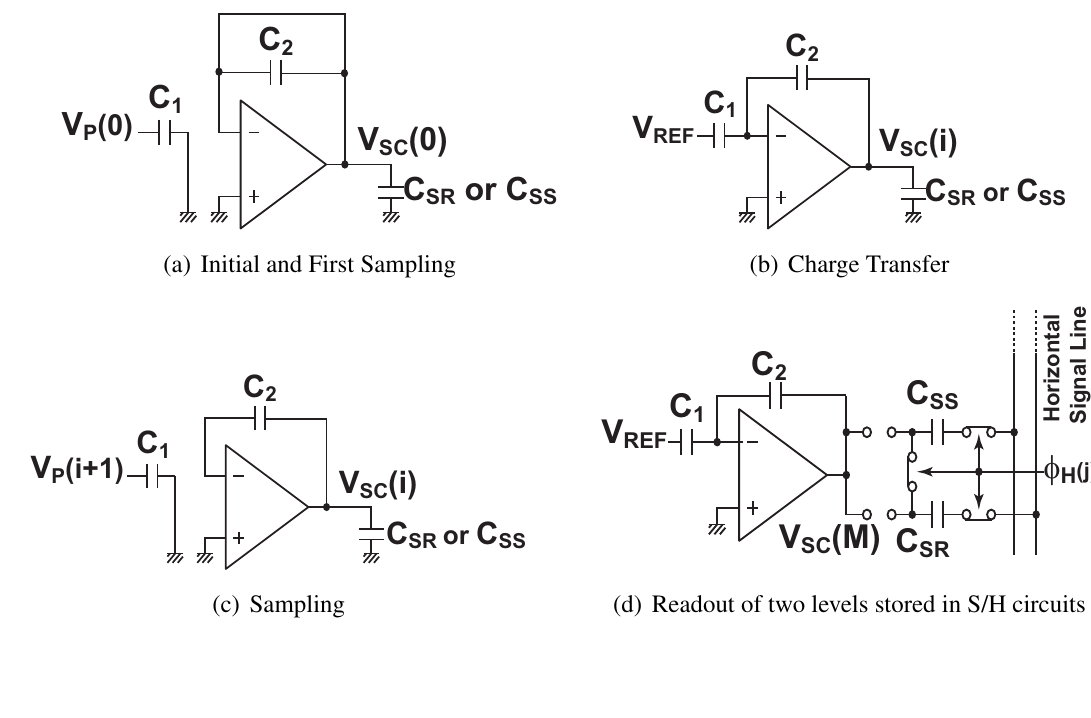
Figure 2. Phase Diagram of Correlated Multiple Sampling